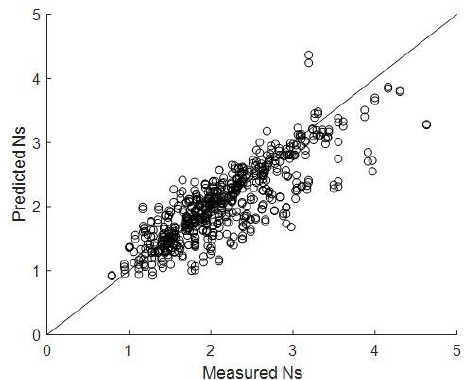
Figure 1. A comparison between the measured and the predicted stability numbers by Van der Meer’s formula.